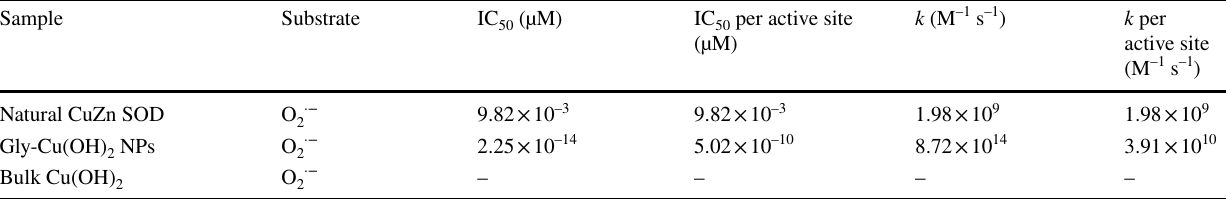
Table 4 SOD-like catalytic activities of natural CuZn SOD, Gly-Cu(OH) 2 NPs, and bulk Cu(OH) 2 Sample